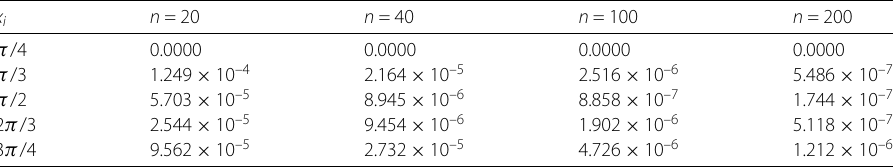
Table 2 The maximum absolute error | u (cid:3) ( x i ) – u (cid:3) n ( x i ) | at α = 1 using RKM